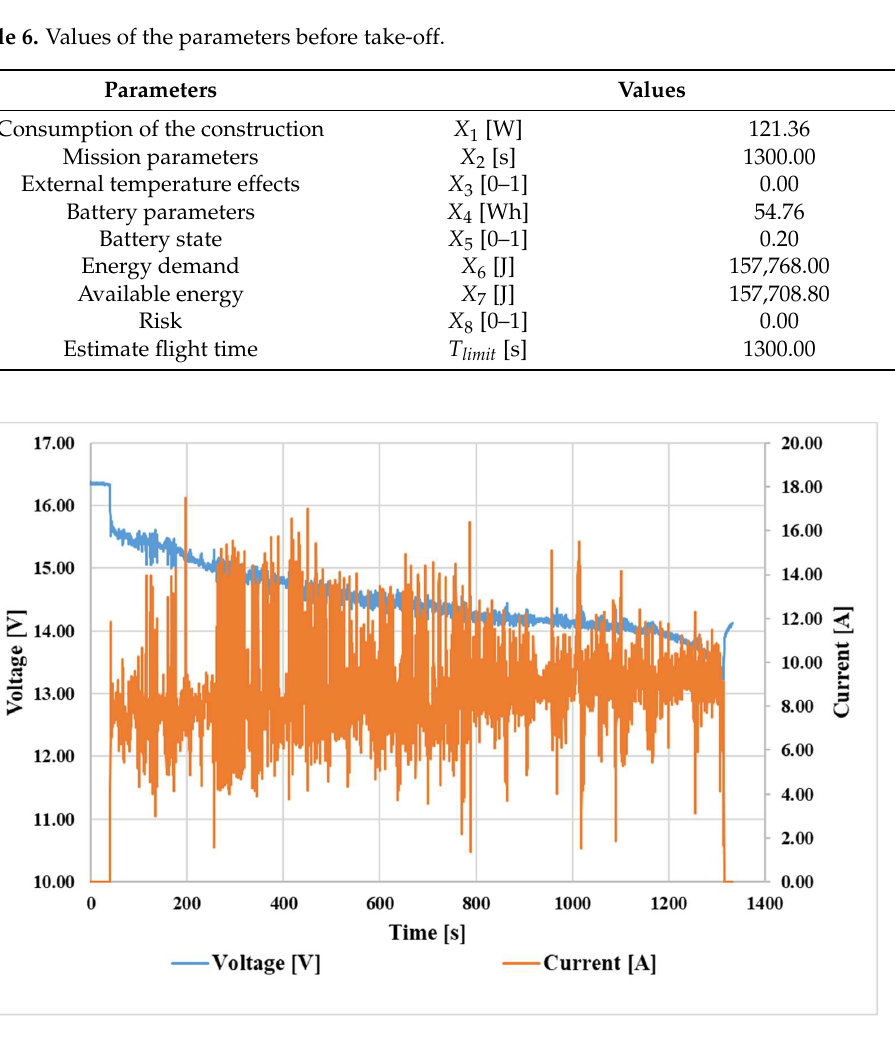
Figure 9. The voltage as a function of the SOC during the measurements. The SOC shown in Figure 9 was determined using the Coulomb Counting method. The initial value was the nominal maximum level of the ba(cid:308)ery, and the minimum level was the limit of 20%. As a practical consideration, even in most automatic-factory setups, the last 20% SOC is not used by the UAV. Since load spikes can be dangerous below this level, usable capacity is set at 80%. Modifications had to be made to the model to determine the theoretical in-flight risk, or it depended on the ba(cid:308)ery charge and load levels. An increase in load C-rate may result, for example, from higher winds, and so on. The relationship between risk and SOC was determined based on Figure 4, and the relationship between load magnitude and risk is shown in Figure 10.